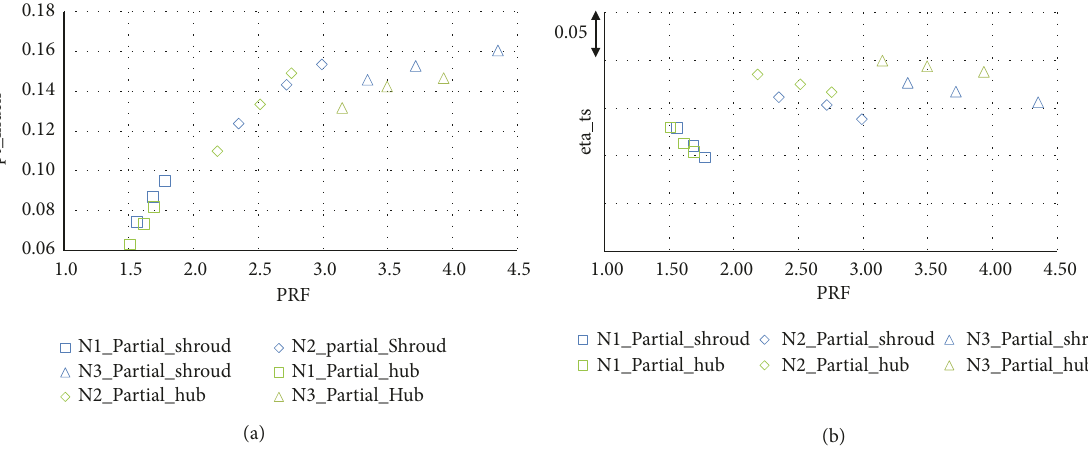
Figure 25: Performance comparison between partial shroud and partial hub without backside cavity: (a) total pressure index and (b) total- to-static efficiency vs